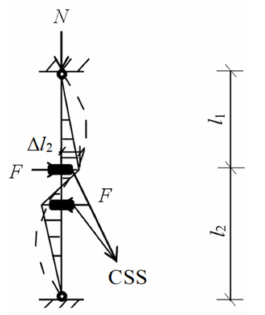
Figure 16. Schematic diagram of ∆ l c